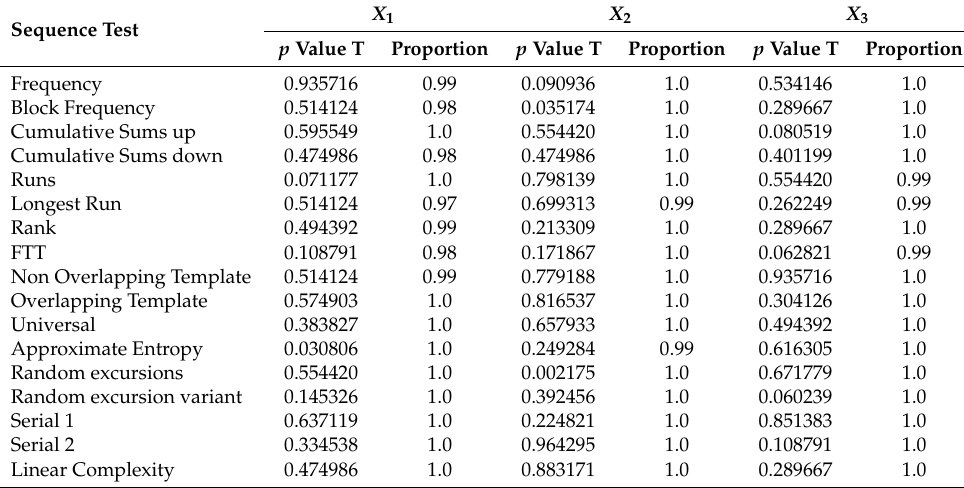
Table 12. Results of the NIST SP 800-22 test to the CPRBG by using Rössler